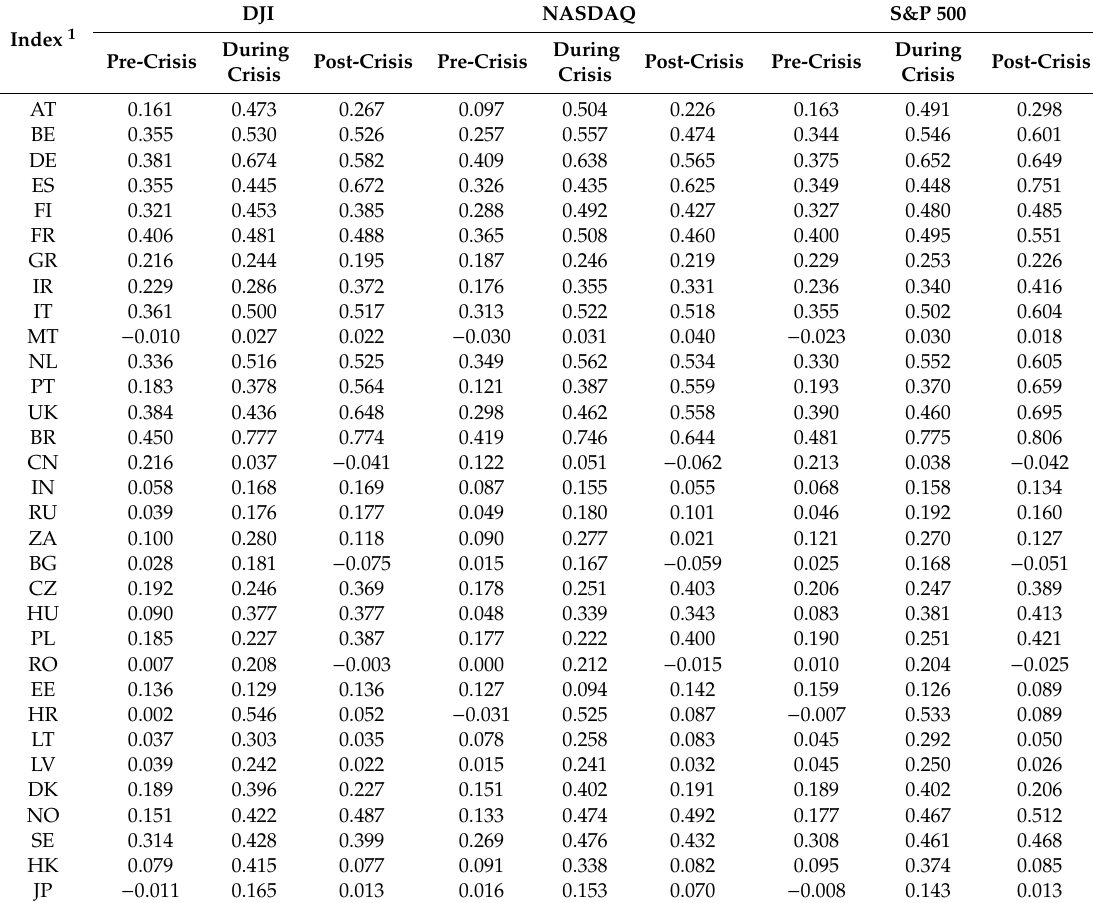
Table 1. Correlation coe ffi cients for squared stock index return for Pre-GFC, GFC and